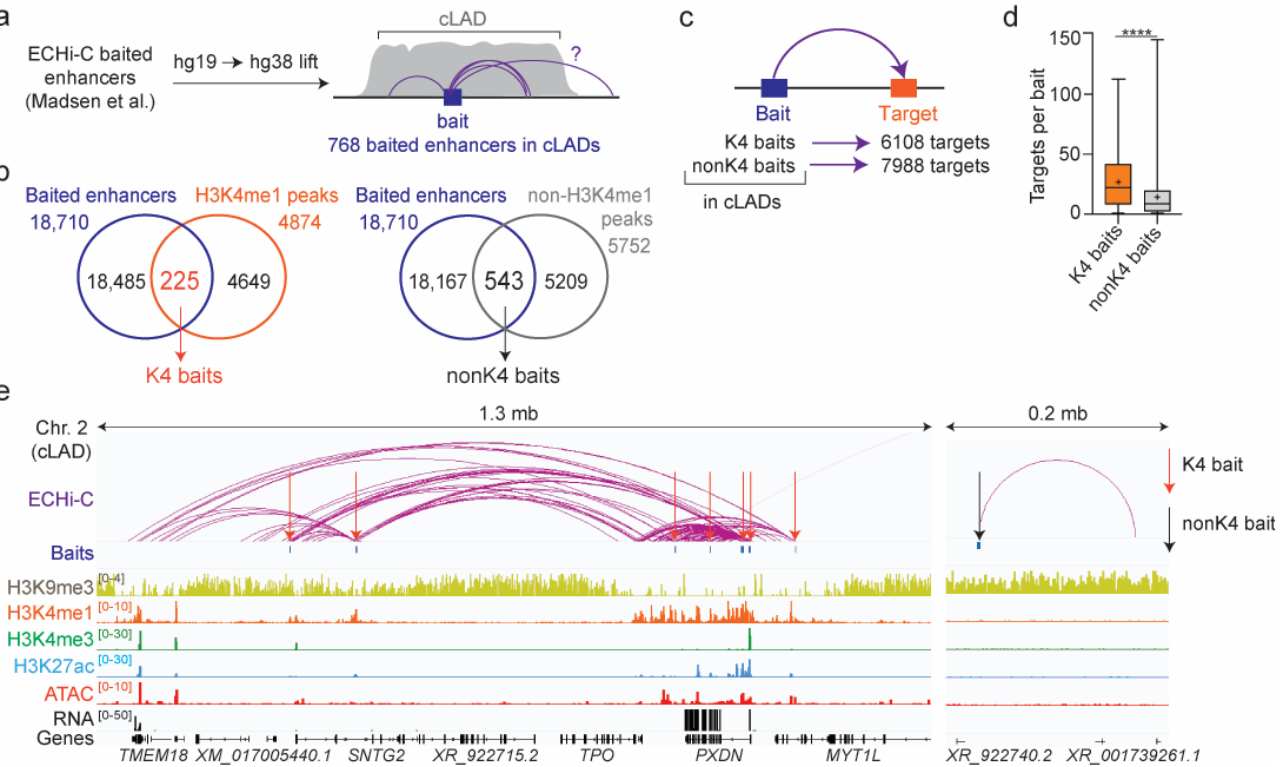
Figure 2. Chromatin interactions at the nuclear lamina. ( a ) Numbers of ECHi ‐ C baited enhancers from Madsen et al. [21] (baits) mapped to the cLADs of our study. ( b ) Baited enhancers intersecting with H3K4me1 peaks (K4 baits) or non ‐ H3K4me1 peaks (nonK4 baits) in cLADs. ( c ) Numbers of ECHi ‐ C targets of cLAD K4 baits and nonK4 baits. ( d ) Numbers of ECHi ‐ C targets per K4 and nonK4 bait; bar, median; cross, mean; box, 25 ‐ 75% percentile; whiskers, min ‐ max; **** p < 10 − 4 ; unpaired t ‐ test with Welch’s correction. ( e ) Genome browser view of ECHi ‐ C interactions originating from K4 baits (red arrows) and from a nonK4 bait (black arrow) in a cLAD, with underlying histone modifications and ATAC sites. Gene expression is shown (RNA). Histone ChIP ‐ seq and RNA ‐ seq data are from [10]; ATAC ‐ seq data are reprocessed from [37].